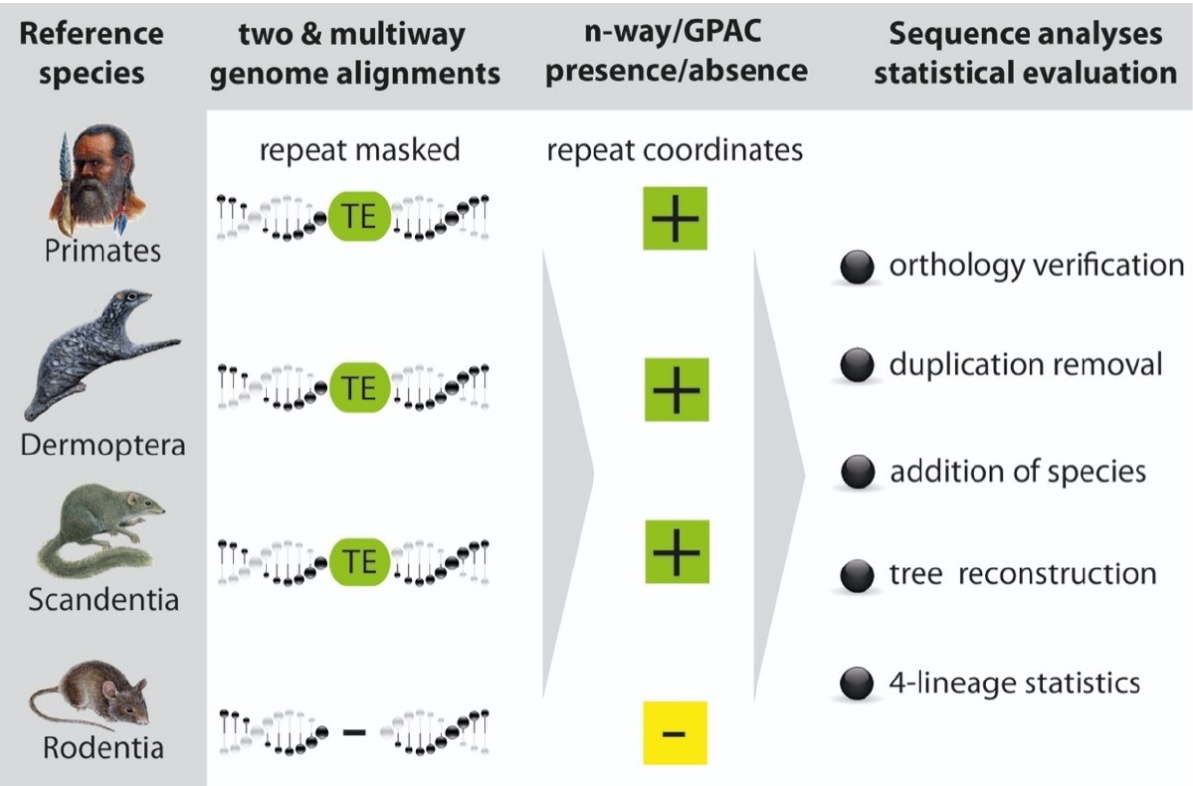
Figure 1. Procedure to screen for phylogenetically diagnostic TE presence/absence patterns. Reference species are shown on the left. We applied multi-way and combinations of multiple 2-way genome screenings for diagnostic TEs. All investigated genomes were previously repeat masked. Repeat coordinates were sorted in the genome presence/absence compiler (GPAC) (multi-way genome alignments) and 2-n-way (combinations of 2-way alignments) for their presence (+) or absence ( − ). In addition to presence/absence patterns, 2-n-way also provided the necessary sequence alignments that were carefully checked manually to verify orthology and remove duplicated loci. For GPAC, we compiled and verified alignments previously retrieved from genomic coordinates. Additional species needed for verifying the consistent presence of elements in each group were added via manual blast screening. The final steps of analysis involve tree reconstruction and 4-lineage statistics (4-LIN) to determine the significance of the trees.